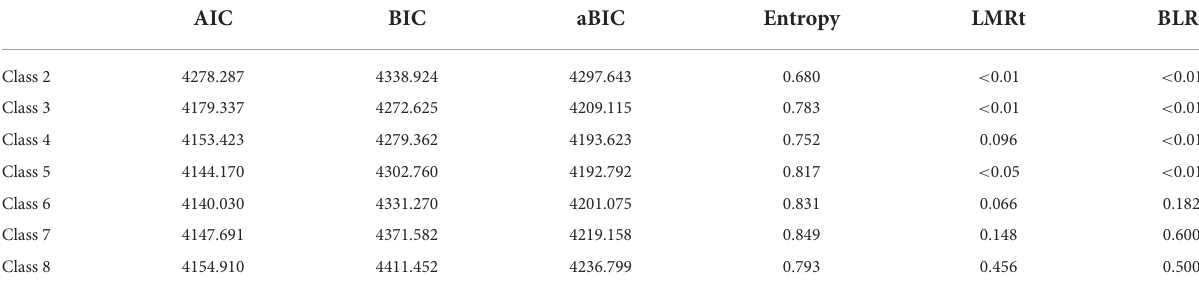
TABLE 2 Fit indices for latent class analysis (LCA) models with 2–8 classes.